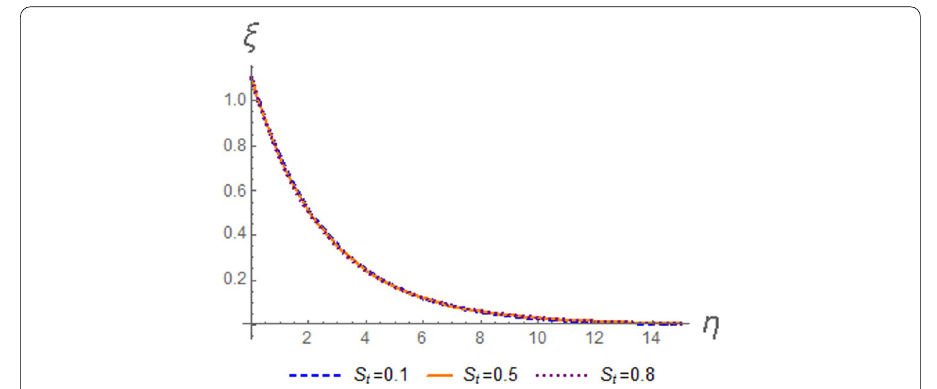
Fig. 16 Effect of S t on the temperature profile